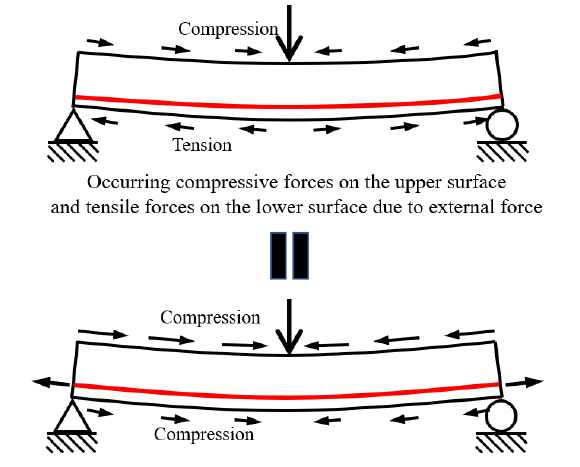
Figure 3. Pre-stressed concrete concept.